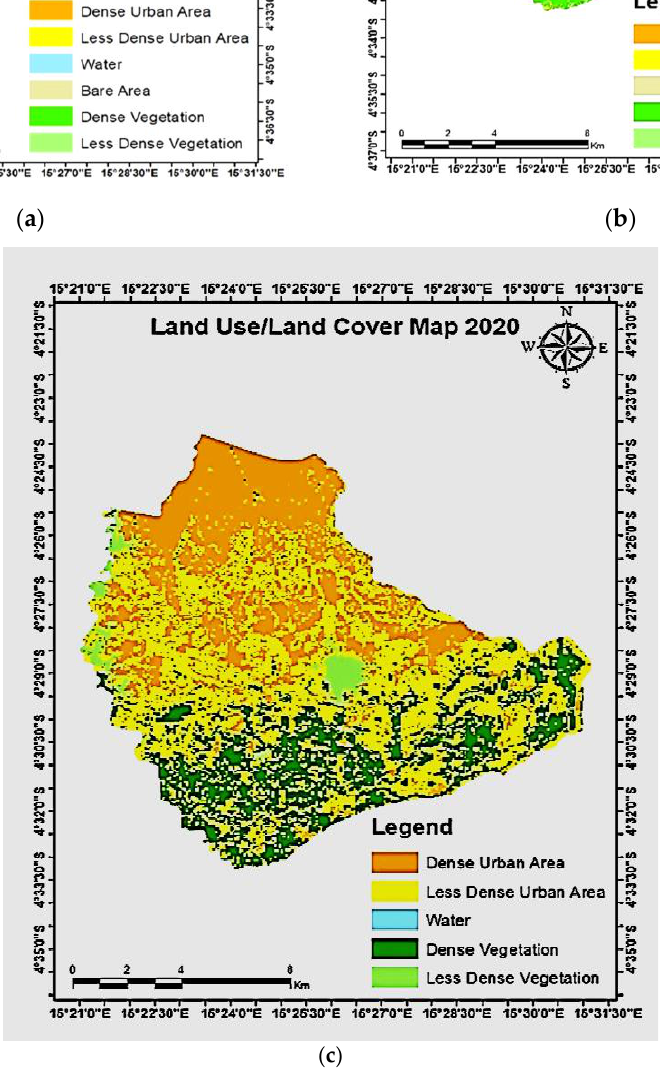
Figure 7. ( a , b ) Land used/cover for (2010, 2015). ( c ). Land used/cover for 2020.